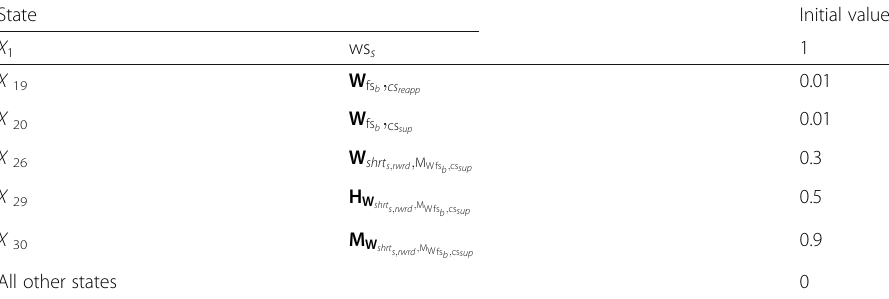
Table 3 Initial values of the